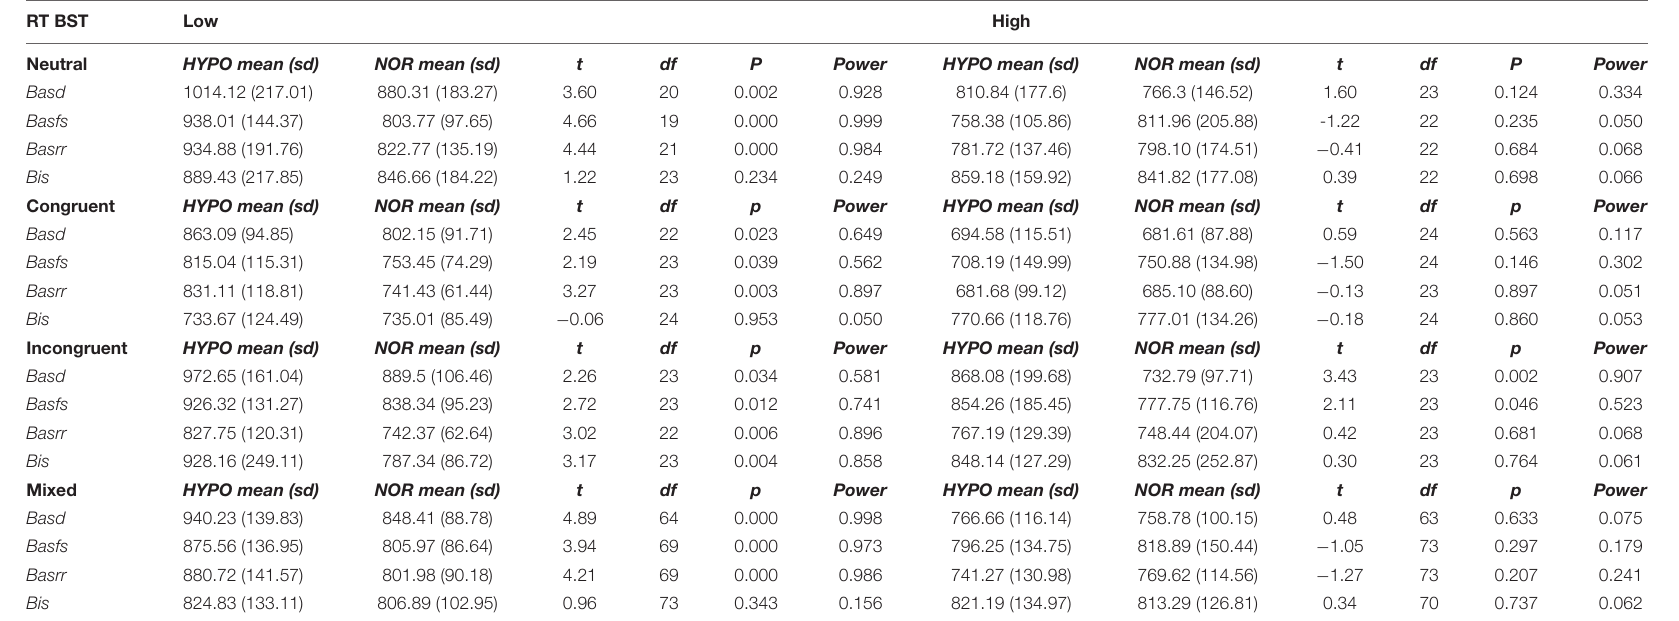
TABLE 3 | Paired sample t -test of time reactions BST for low vs. high BAS groups across hypoxia-normoxia